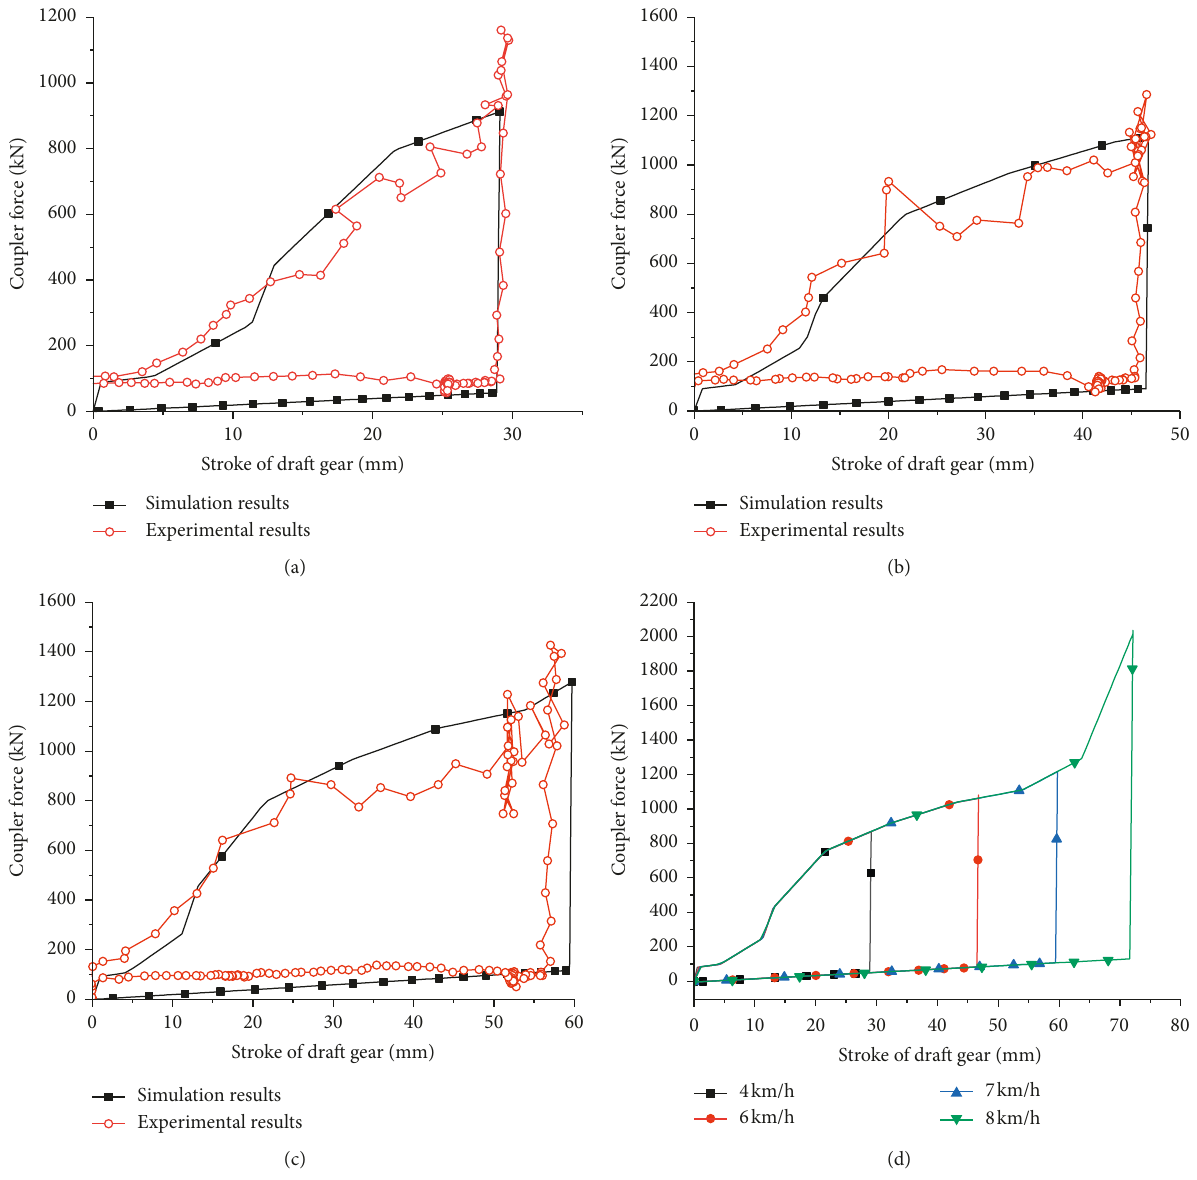
Figure 6: Shunting impact simulation with the lookup table model and comparisons of simulation results. (a) 4km/h shunting impact simulation and test results. (b) 6 km/h shunting impact simulation and test results. (c) 7km/h shunting impact simulation and test results. (d) Comparison of the simulation results at different initial